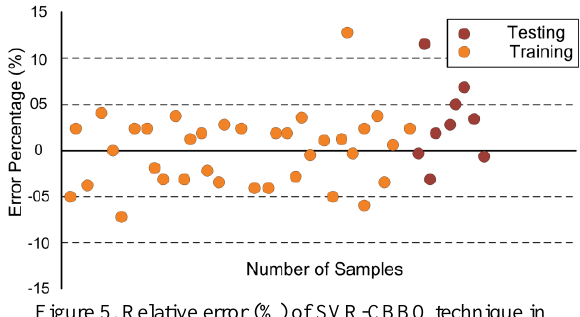
Figure 5. Relative error (%) of SVR-CBBO technique in displacement